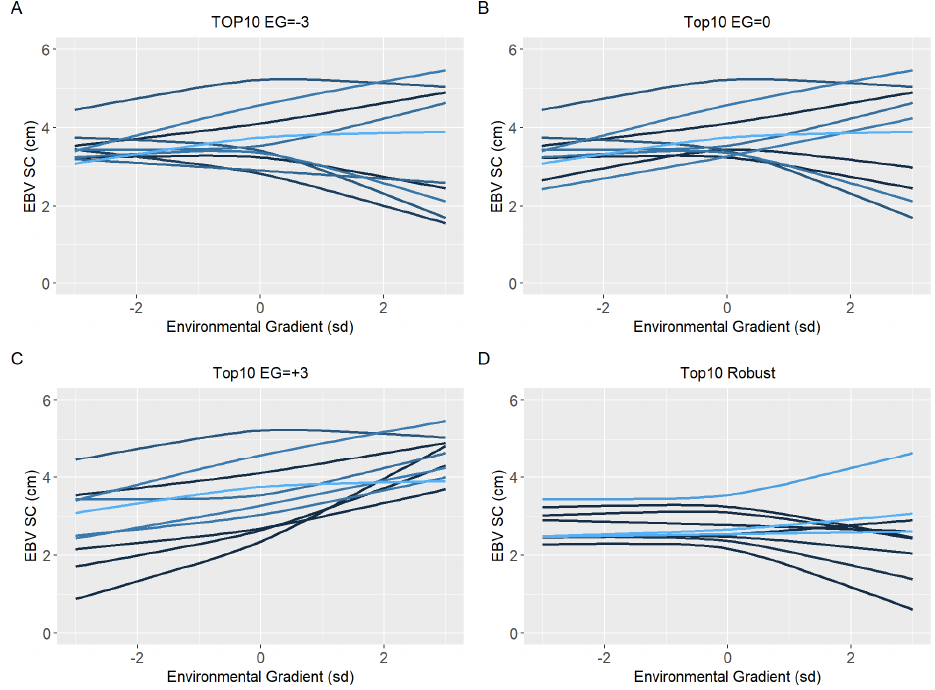
Figure 8. Estimated breeding values (EBV) reaction norms for scrotal circumference (SC) of Nellore cattle sires classified as top 10 for low ( A ), medium ( B ), and high environmental gradient ( C ), and top 10 robust ( D ) considering the reaction norm models (RNM) fitted with spline linear–linear heteroscedastic (RNM_l-l).